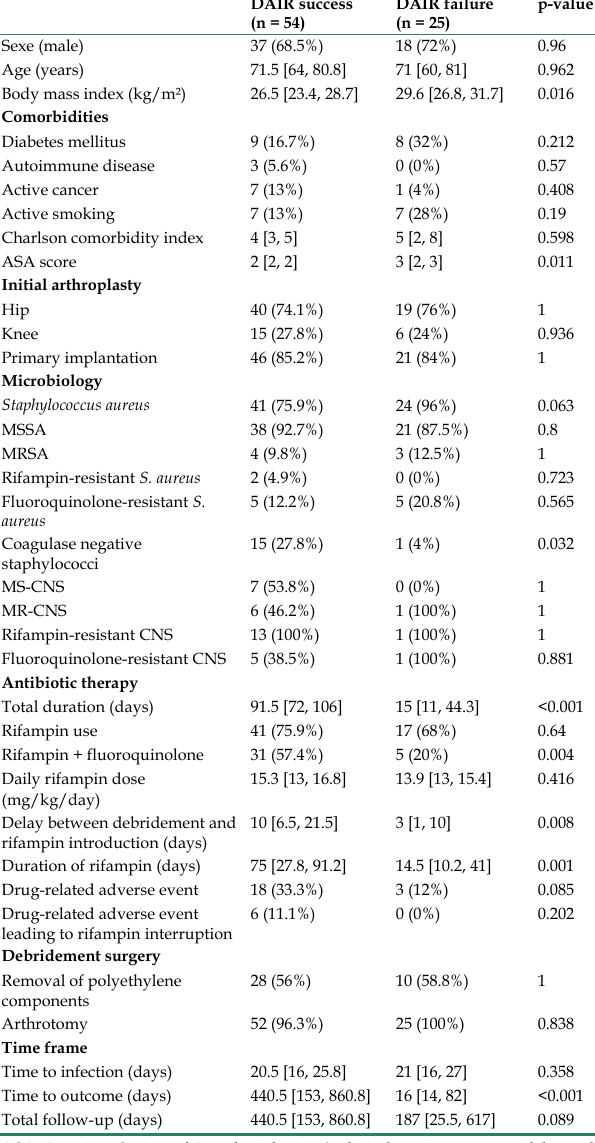
Table 1. Baseline characteristics of patients included, microbiology data, therapeutic characteristics and follow-up Table 2. Hazard-ratios of treatment failure in univariate Cox regression analysis